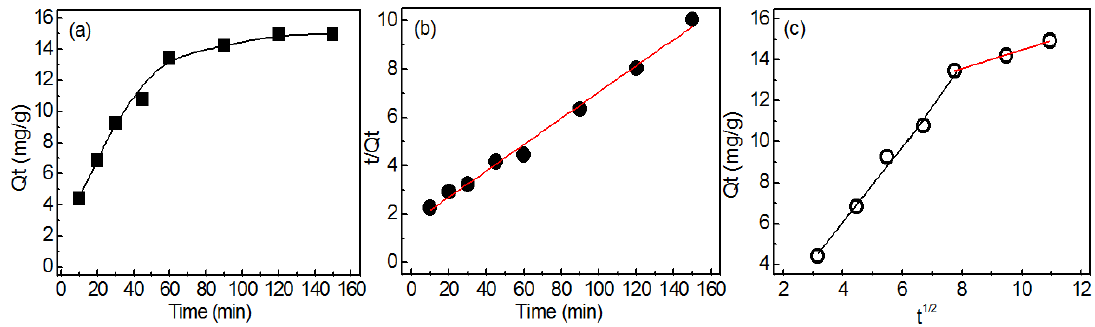
Figure 8. Adsorption kinetics of phosphate removal onto QCLF in 50 mL, 20 mg/L, 0.05 g, pH: 7, ( a ) effect of adsorption time; ( b ) pseudo-second-order kinetic model; ( c ) intra-particle diffusion model. Intra-particle diffusion model was also used to study the transportation of phosphate to QCLF.